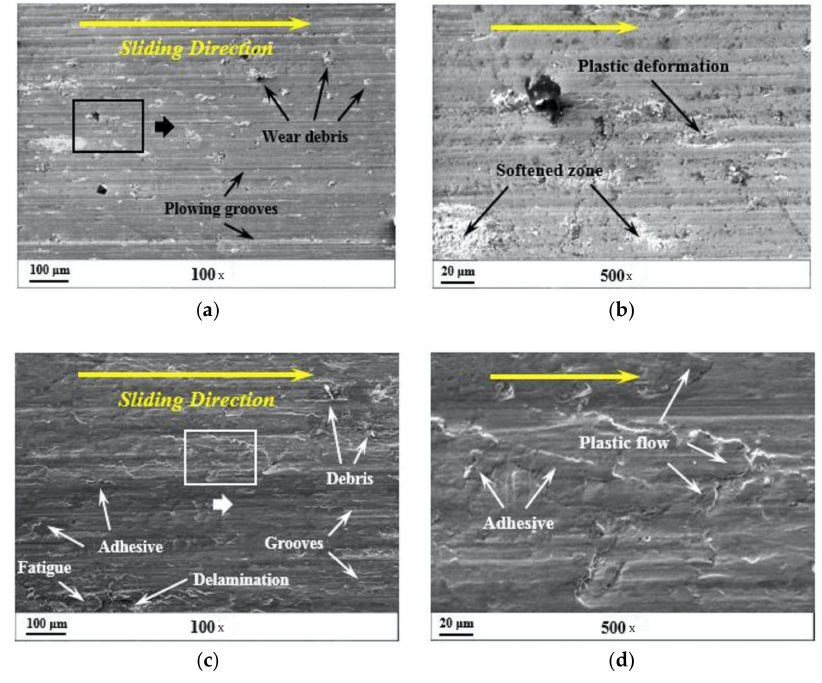
Figure 4. The worn surface morphology of ZrO 2 -toughened Al 2 O 3 particles reinforced high- chromium cast iron (HCCI) matrix composite at different loads: ( a ) 300 N-low magnification; ( b ) 300 N-high magnification; ( c ) 900 N-low magnification; and ( d ) 300 N-high magnification